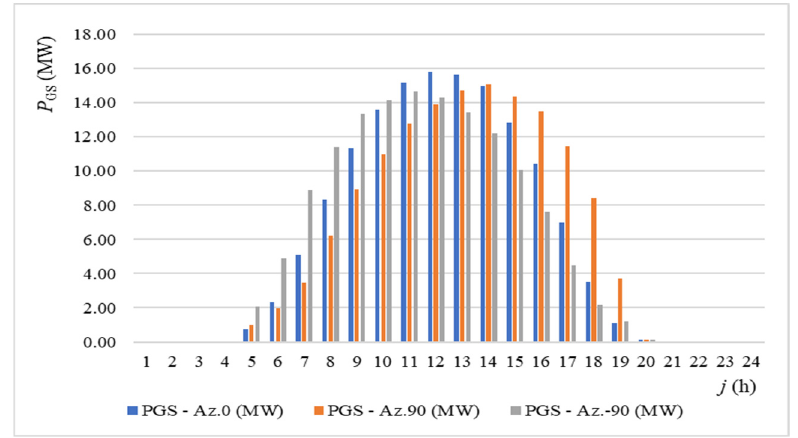
Figure 7. Daily output power of the SPP for case 1.